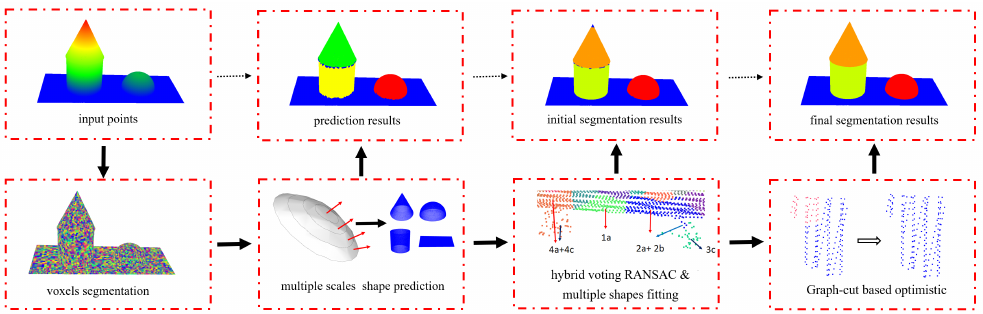
Figure 2. The overall workflow of the proposed